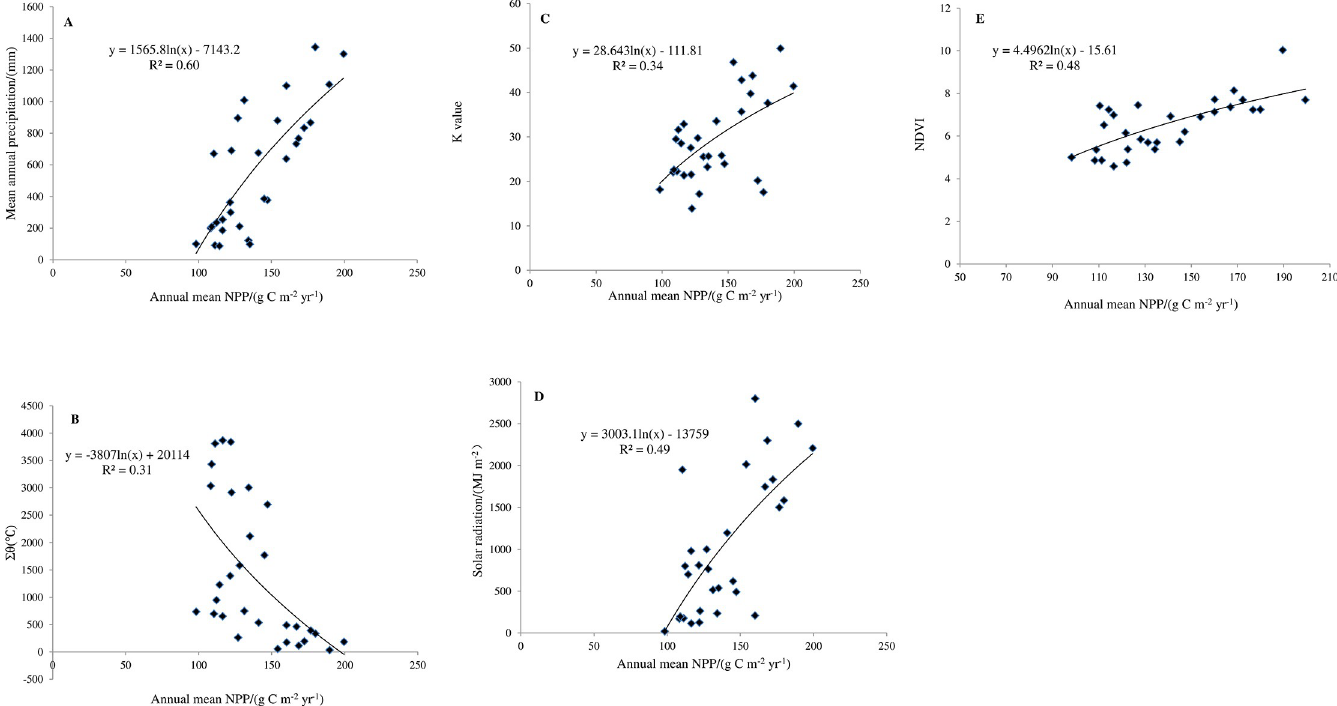
Fig 7. Correlation analysis between annual mean grassland NPP and climate factors in Gansu, China from 1982 to 2011.